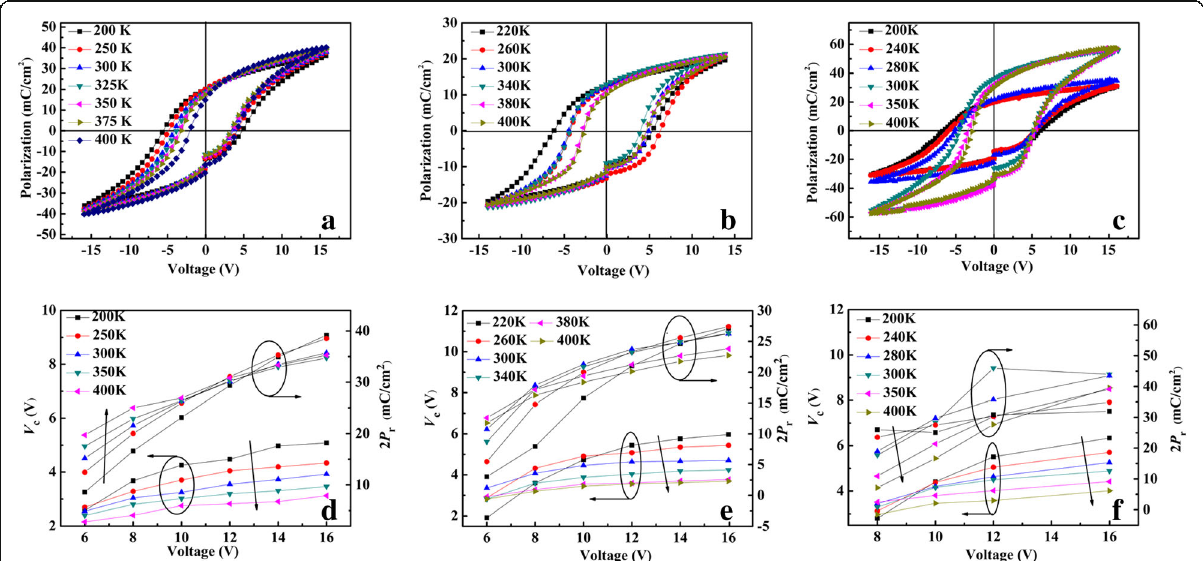
Fig. 3. P - V hysteresis loops measured with the V m of 16 V at 1 kHz and plots of V c and 2 P r as functions of V m at elevated temperatures: a , d for BNTM-1; b , e for BNTM-2; c , f for